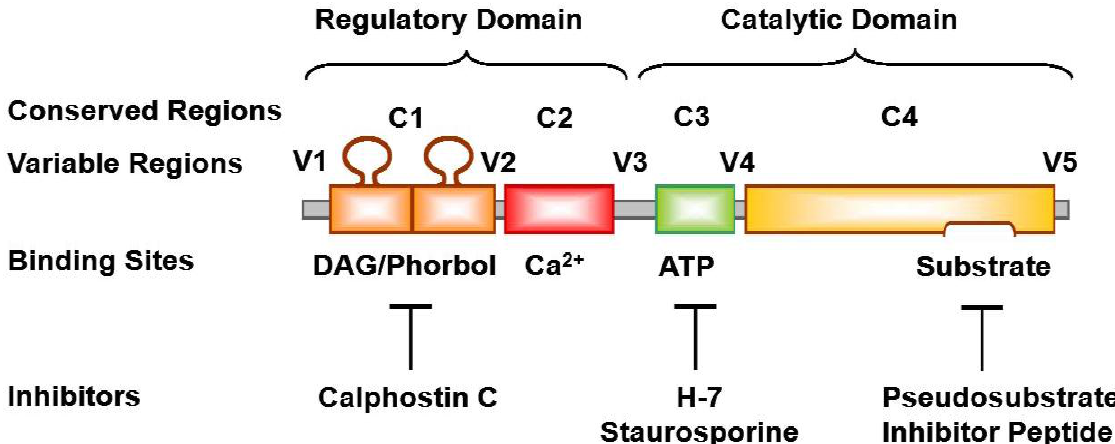
Figure 2. Biochemical structure of a classic PKC, and sites of action of activators and inhibitors. A classic PKC molecule has four conserved (C1–C4) and five variable (V1–V5) regions. C1 region contains binding sites for DAG, phorbol ester, and phosphatidylserine, and for the PKC inhibitor calphostin C. C2 region contains Ca 2+ -binding site. C3 regions contain binding sites for ATP and the PKC inhibitors H-7 and staurosporine. C4 region contains binding sites for physiological PKC substrate. Endogenous pseudosubstrate and exogenous pseudosubstrate inhibitor peptide bind to the catalytic domain and prevents PKC from phosphorylating the true substrate. Upon activation, the PKC molecule unfolds to remove endogenous pseudosubstrate, and bring ATP into proximity with the